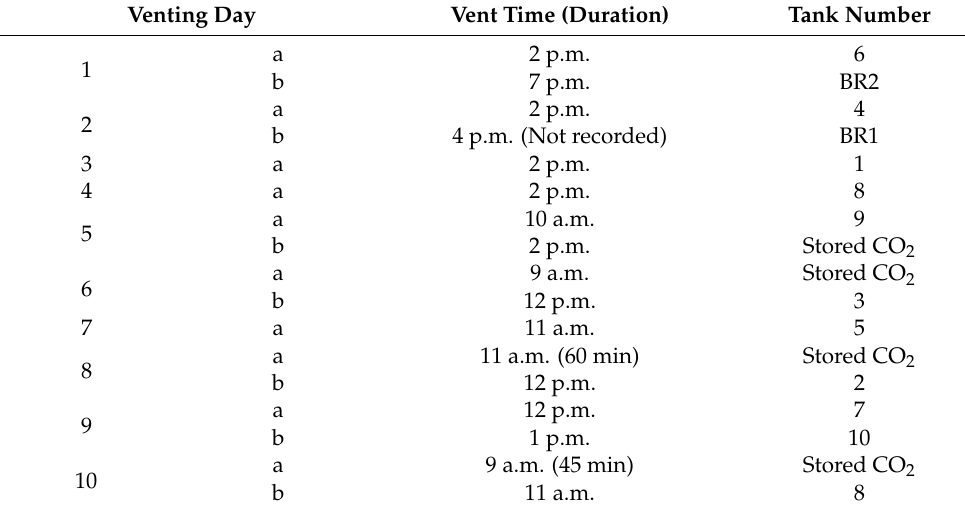
Table 1. A 10-day subset of CO 2 venting events within the brewery. Vents occurred for a duration of approximately 30 min, unless otherwise